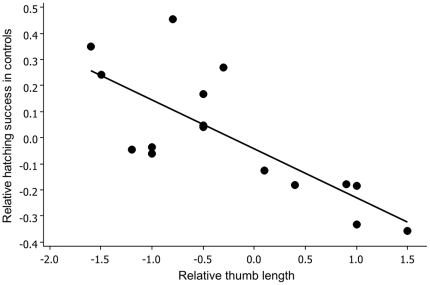
Relationship between the differential hatching success of males in controls and their differential thumb length (F
2, 20  = 17.7, P = 0.0012).